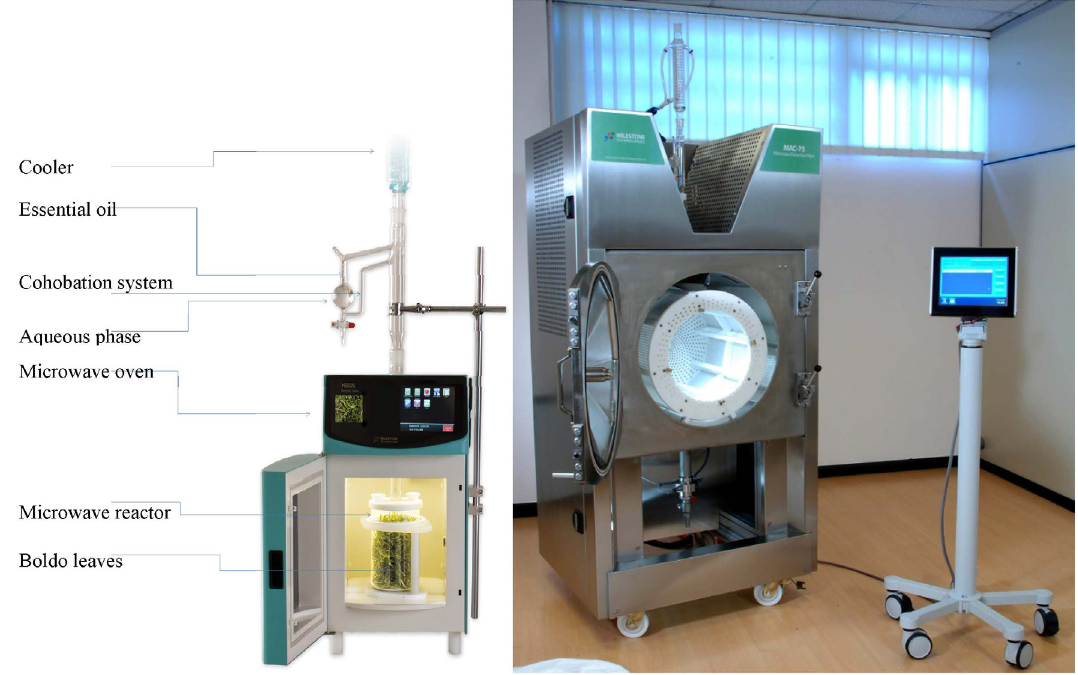
Figure 7. Laboratory and pilot scale microwave